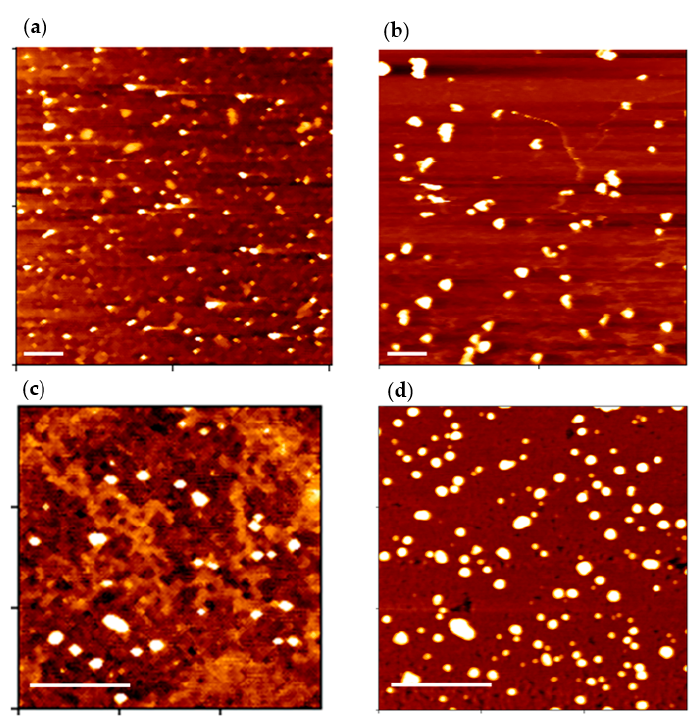
Figure 5. Atomic force microscopy (AFM) of the particles formed by p116 and p73. ( a ) An AFM image of particles assembled by p116 alone; ( b ) an AFM image of particles formed by p116 interacting with fluorescent tRNA during particle formation; ( c ) an AFM of particles assembled by p73 alone; ( d ) an AFM image of particles formed by p73 in the presence of fluorescent tRNA during the particle formation. In all these images, nucleocapsid-like particles were observed. The images shown are topographic images of AFM. Samples were imaged with a scan rate of 1 Hz and scan resolution of 512 × 512 pixels. The force applied by the AFM probe to the samples was 1 nN. The scale bar in each image represents 1 µ